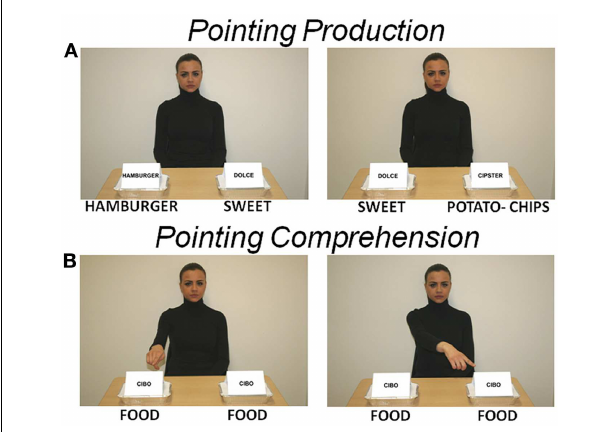
FIGURE 1 | Stimulation pictures .The character looks at the subject. (A) Two take-away trays are located on the table. Each tray is marked with a label, one showing the name of a salty food (English translation has been added immediately below each picture) and the other the generic word “dolce” (sweet). Salty and sweet foods represent target and control stimuli, respectively.These pictures were used to elicit an imperative or declarative pointing on subject (POINTING PRODUCTION). (B) Both trays show the word “cibo” (food) and the character points with the right index finger toward either the tray on the right or on the left.These pictures were used to elicit an imperative or declarative pointing observation and comprehension on subject (POINTING COMPREHENSION). Subject passively looked at picture, no pointing had to be produced by the subject.